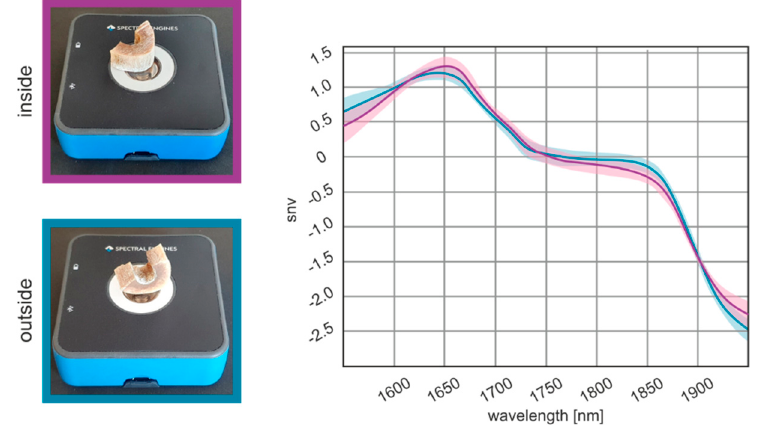
Figure 3. Effects of measurement location on spectra quality. NIR spectra from human bone samples measured externally and the internally, displayed in the range from 1950 to 1550 nm.